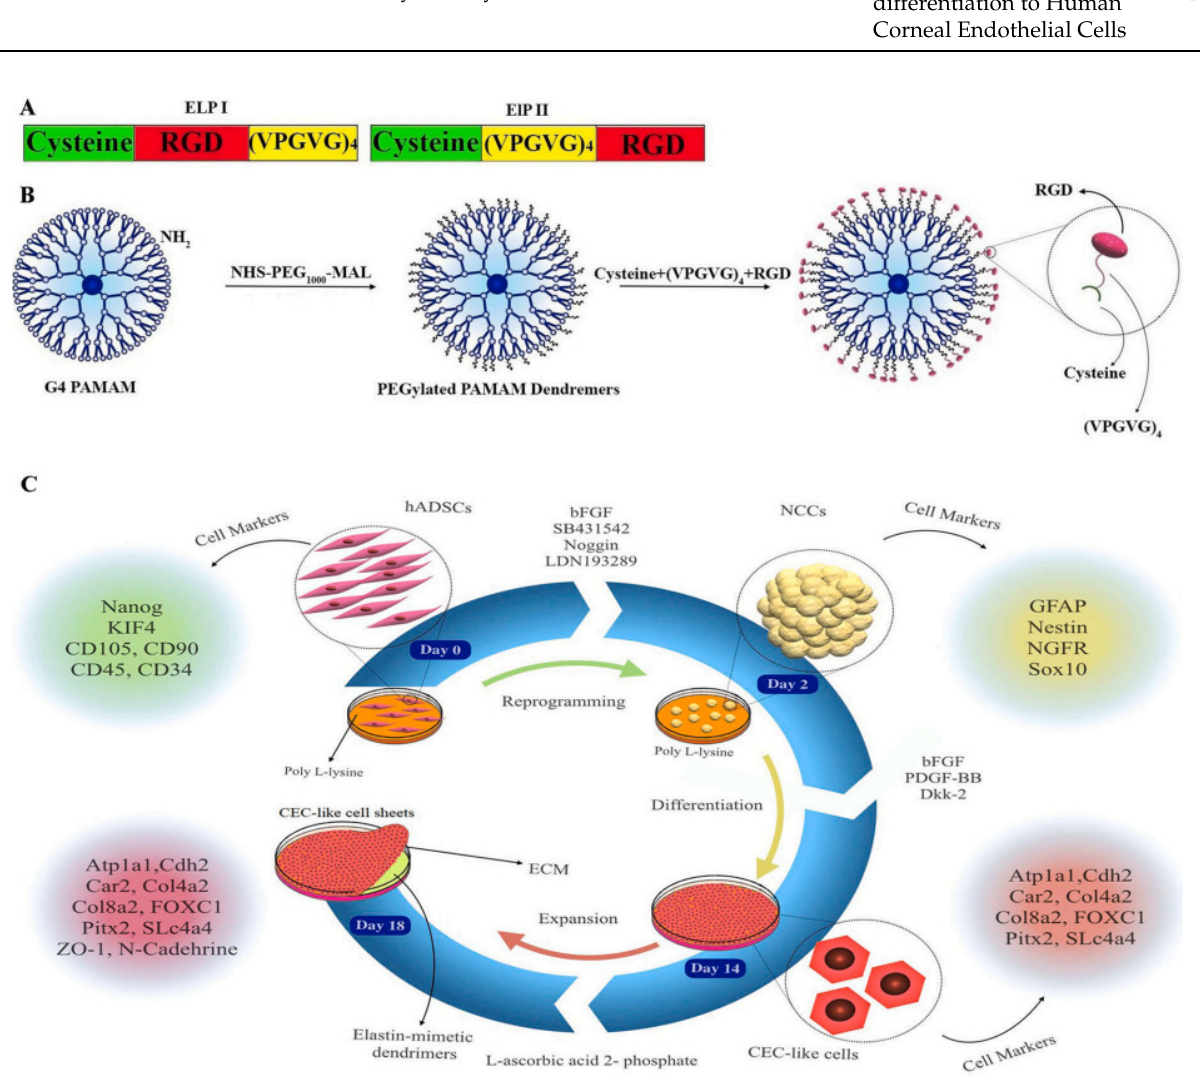
Figure 28. ( A ) Schematic representation of the amino acid sequences. ( B ) Schematic diagram for the synthesis of temperature-sensitive elastin mimetic dendrimers. ( C ) Stages of differentiation of hADSCs into CEC-like cells. Finally, the CEC-like cell sheet formation on thermo-responsive elastin- mimetic dendrimers. The growth factors and specific markers used at each stage of the differentiation protocol are shown. Published under Creative Commons CC-BY license from [269]. Table 5. Dendritic Polymers for the remediation of eyes.